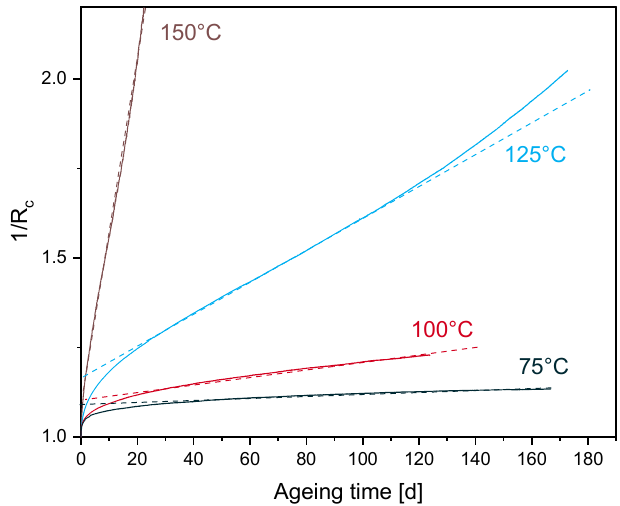
Figure 2. Integrated second order rate plots of EPDM relaxation data at different temperatures (experiment: solid lines, fit: dashed lines).